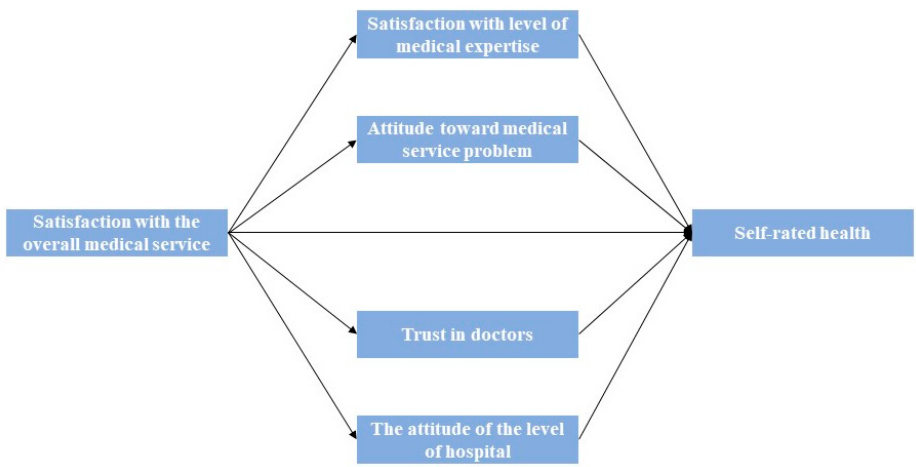
Figure 1. Mediation of the association between public satisfaction with the overall medical service and SRH.